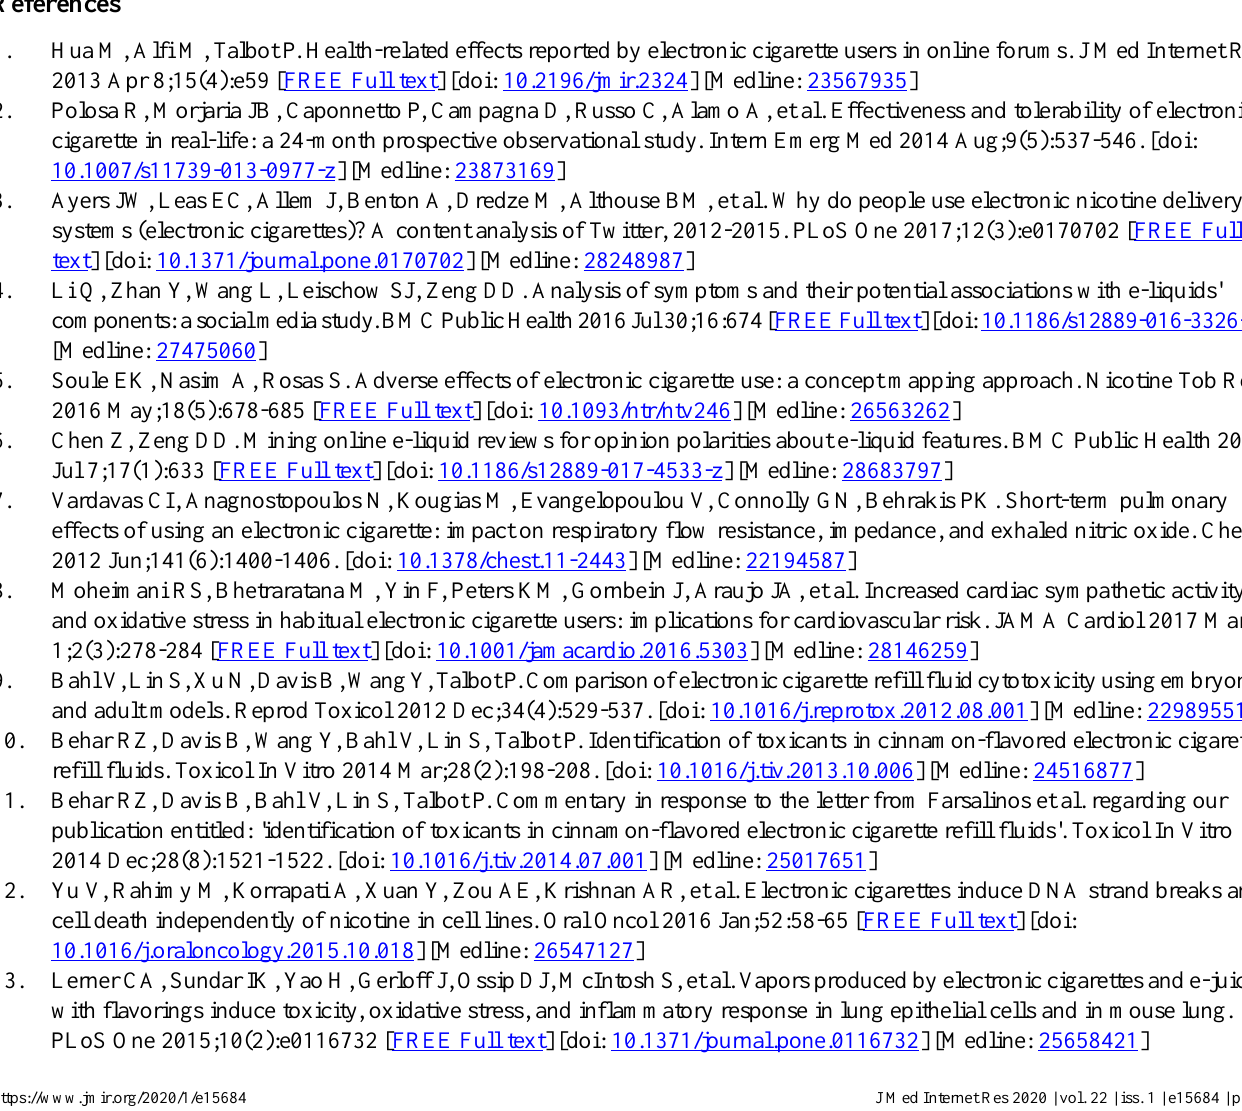
Supplementary Table 2: Listing of all linked symptoms by